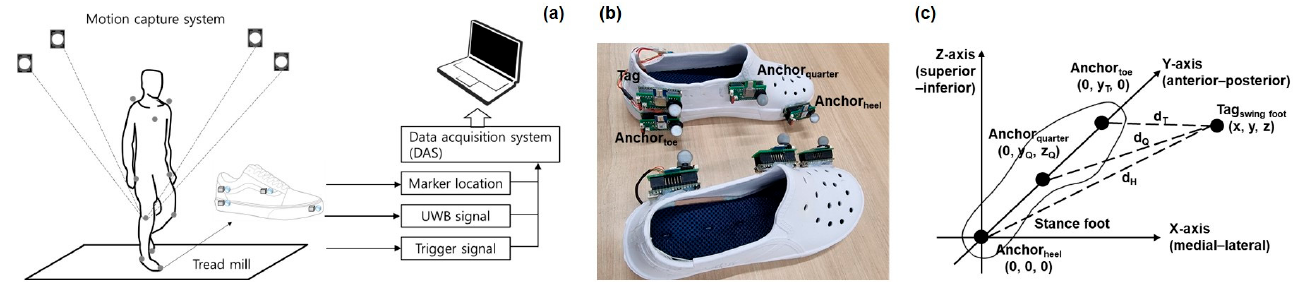
Figure 2. Test setup: ( a ) Data acquisition system; ( b ) UWB and MCS marker installation; ( c ) Coordi- nate system for the UWB sensors.